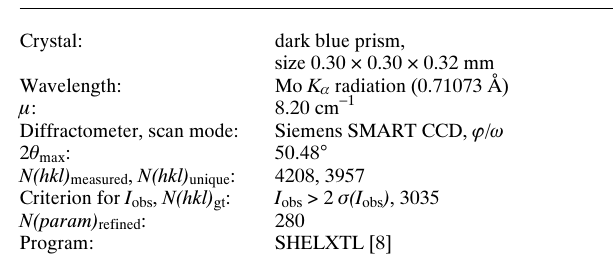
Table 1. Data collection and handling.